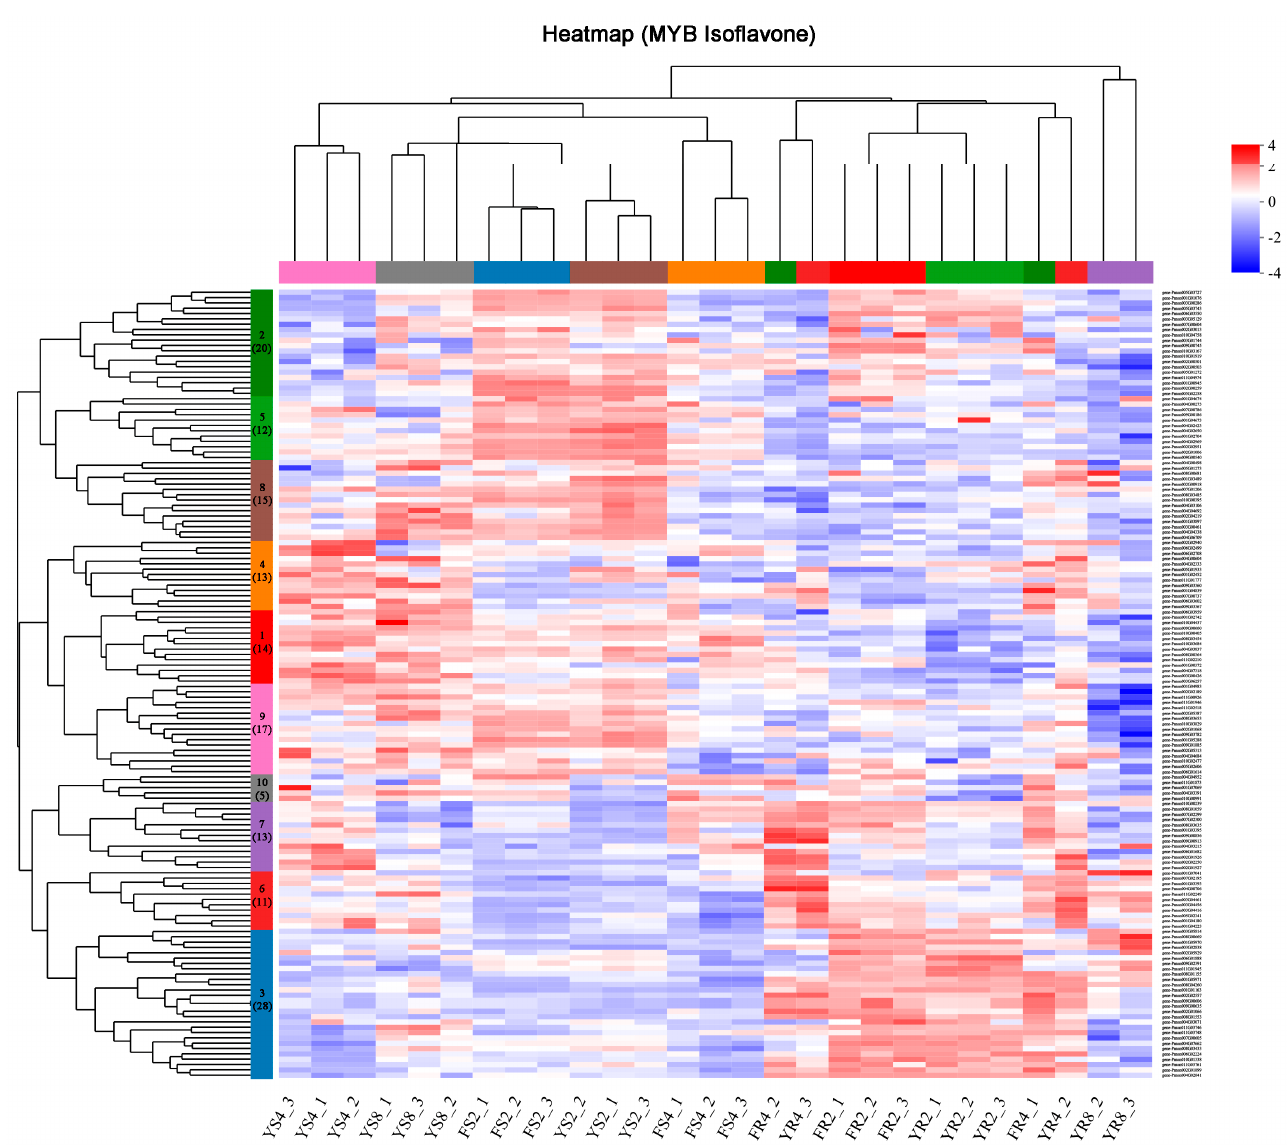
Figure 5. Clustering analysis of the 123 PlMYB sequences according to their expression profiles at the different growth stages of the root and stem tissues of P. lobata (wild) and P. lobata var. thomsonii. FR represents roots of P. lobata var. thomsonii, FS represents stems of P. lobata var. thomsonii, YR represents roots of P. lobata (wild), and YS represents stems of P. lobata (wild). The number next to the sample name indicates the growth stage at which the sample was collected; for example, FR2 represents the 2 ‐ month ‐ old roots of P. lobata var. thomsonii. The number of PlMYBs in each cluster is indicated in brackets.